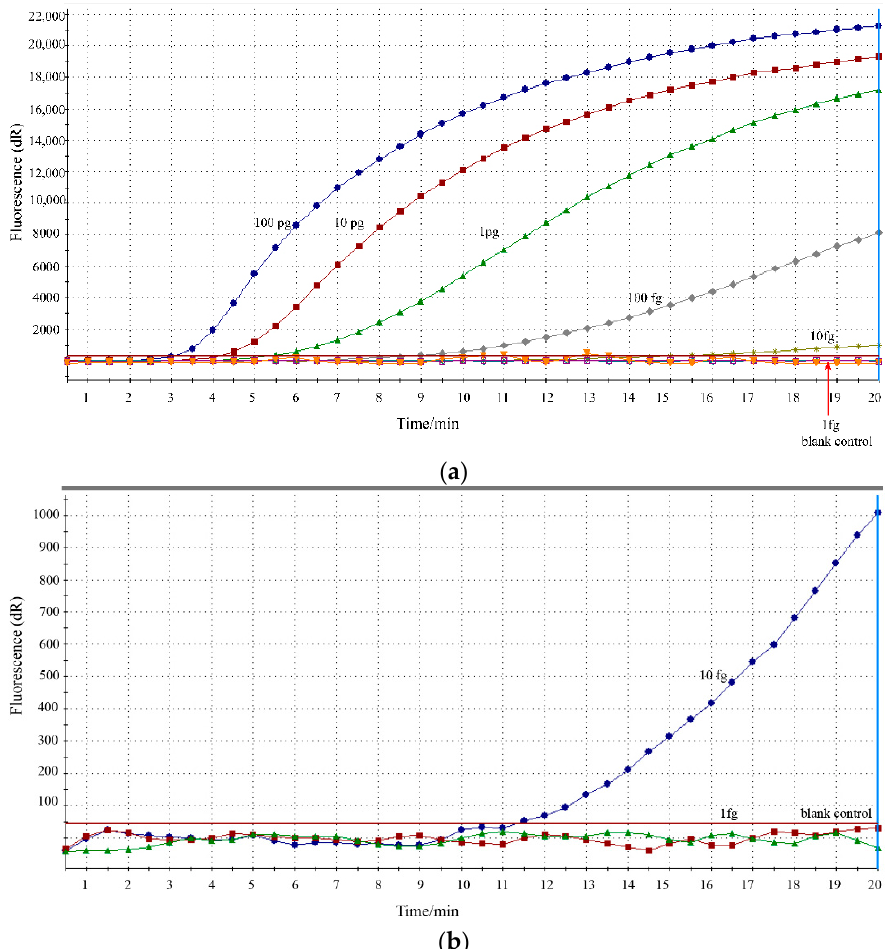
Figure 3. Analytical sensitivity of the RPA assay. ( a ). Sensitivity evaluation was conducted with 10-fold dilutions of M129 DNA templates ranging from 100 pg/ µ L to 1 fg/ µ L; ( b ). The LOD of the RPA assay was 10 fg/ µ L for M. pneumoniae